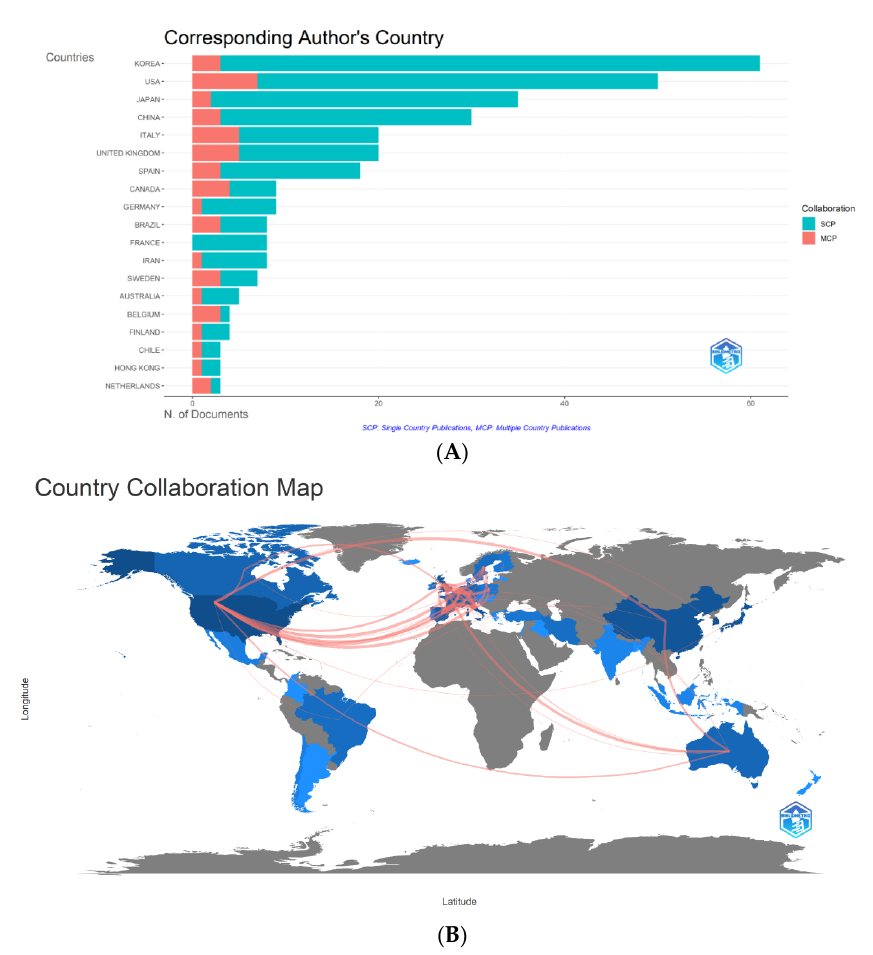
Figure 3. ( A ) Most productive countries and regions in the field of nutrition research works on sarcopenia. ( B ) The collaboration between countries and regions on nutrition research related to sarcopenia. The colour segmentation includes blue (with publications) and grey (without publications). The thickness of the red lines indicates the number of co-published papers. The colour intensity corresponds to the number of publications).